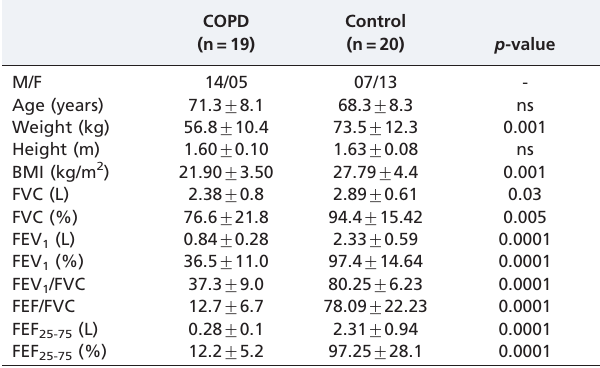
Table 1 - Biometric and spirometric characteristics of the studied